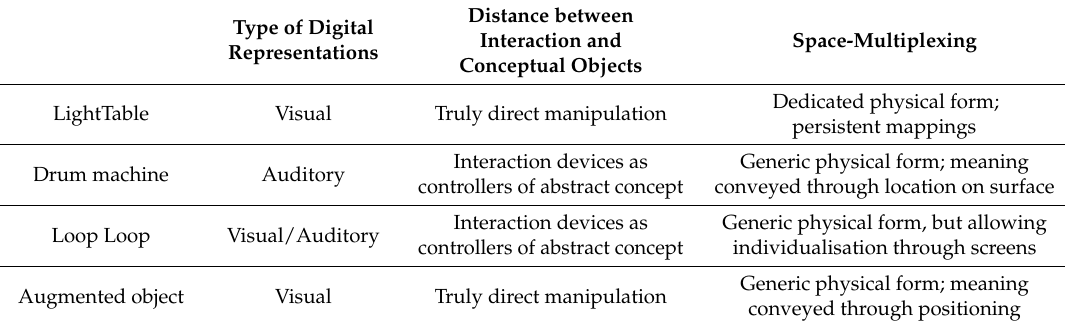
Table 1. Design characteristics of tangibles used in the